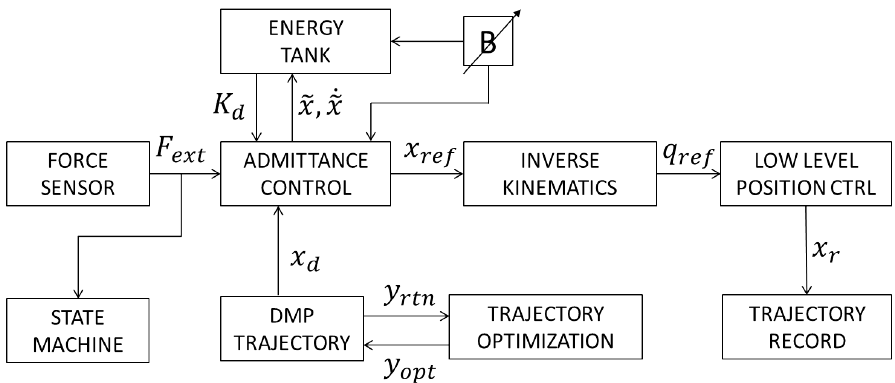
Figure 1. Control architecture of the overall